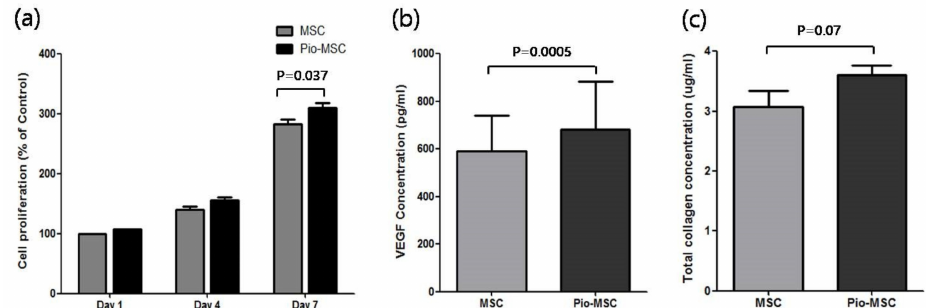
Figure 2. Cell proliferation and relative soluble protein secretion analyses of MSCs and Pio-MSCs. ( a ) Growth profiles were measured in MSCs and pioglitazone-treated MSCs at designated study points. MSCs were cultured in serum free media. MSCs and Pio-MSCs were cultured for 48 h and the concentrations of VEGF ( b ) and collagen ( c ) were measured using ELISA and a SirCol assay,